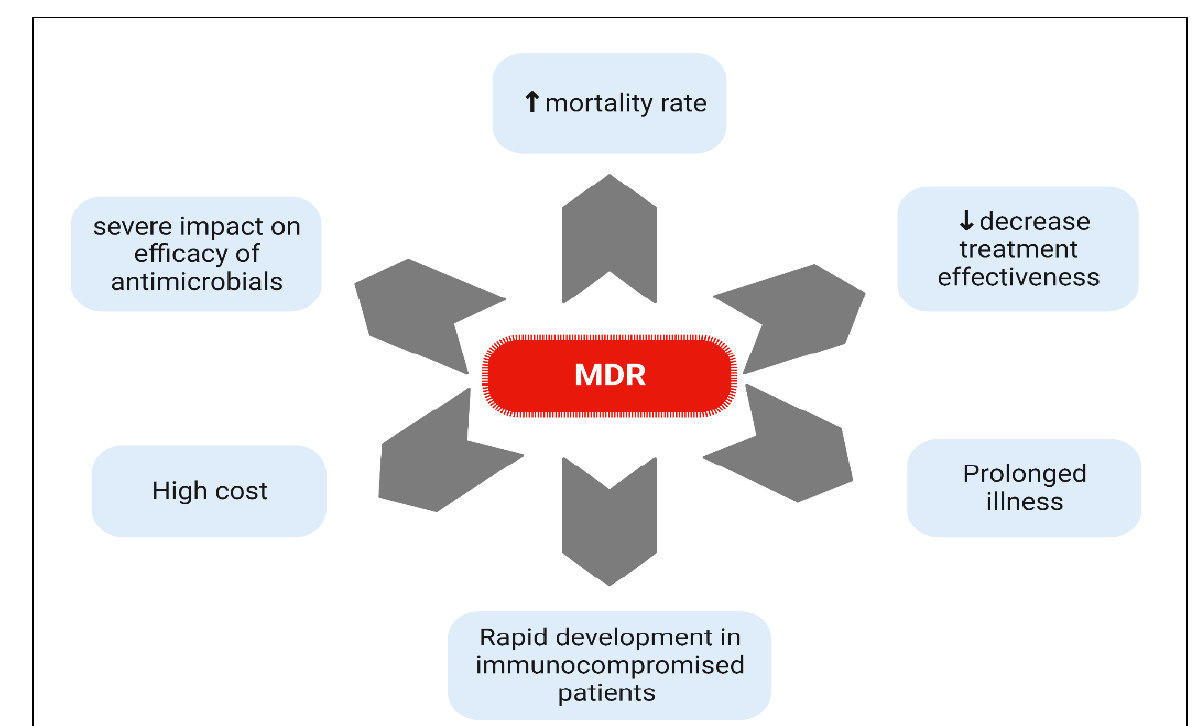
Figure 3. Risk factors related to MDR. MDR increase the risk of mortality rate, decrease in medication efficacy, prolong the period of illness, rapidly develop in immunocompromised patients, are not affected by most antimicrobials and need more expensive alternatives.